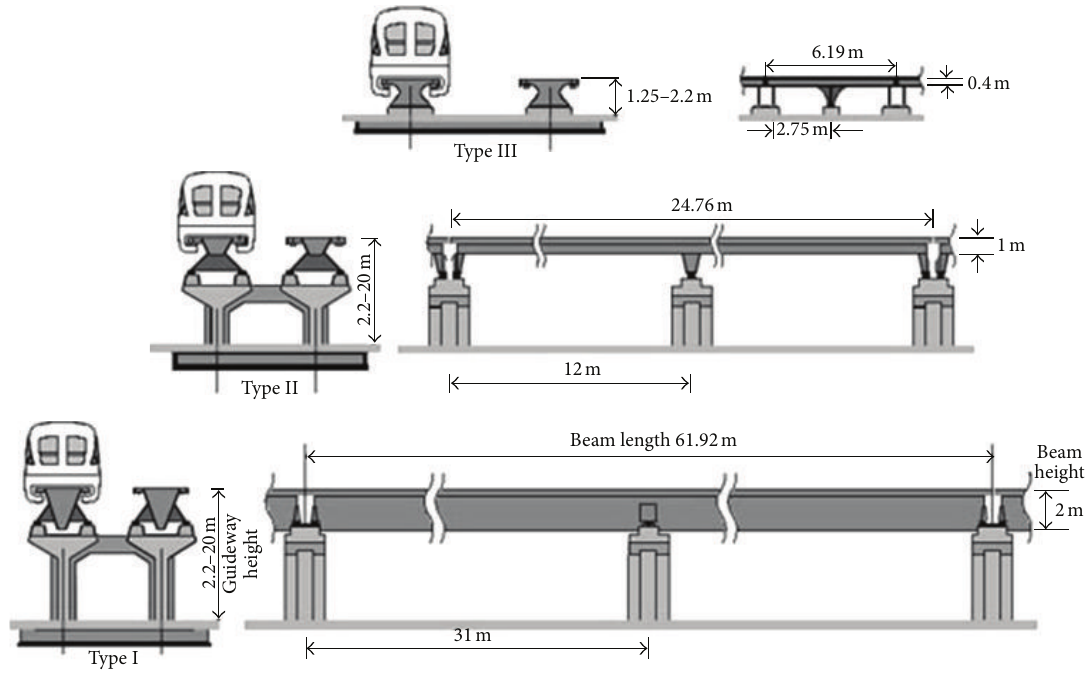
Figure 15: Standard guideway